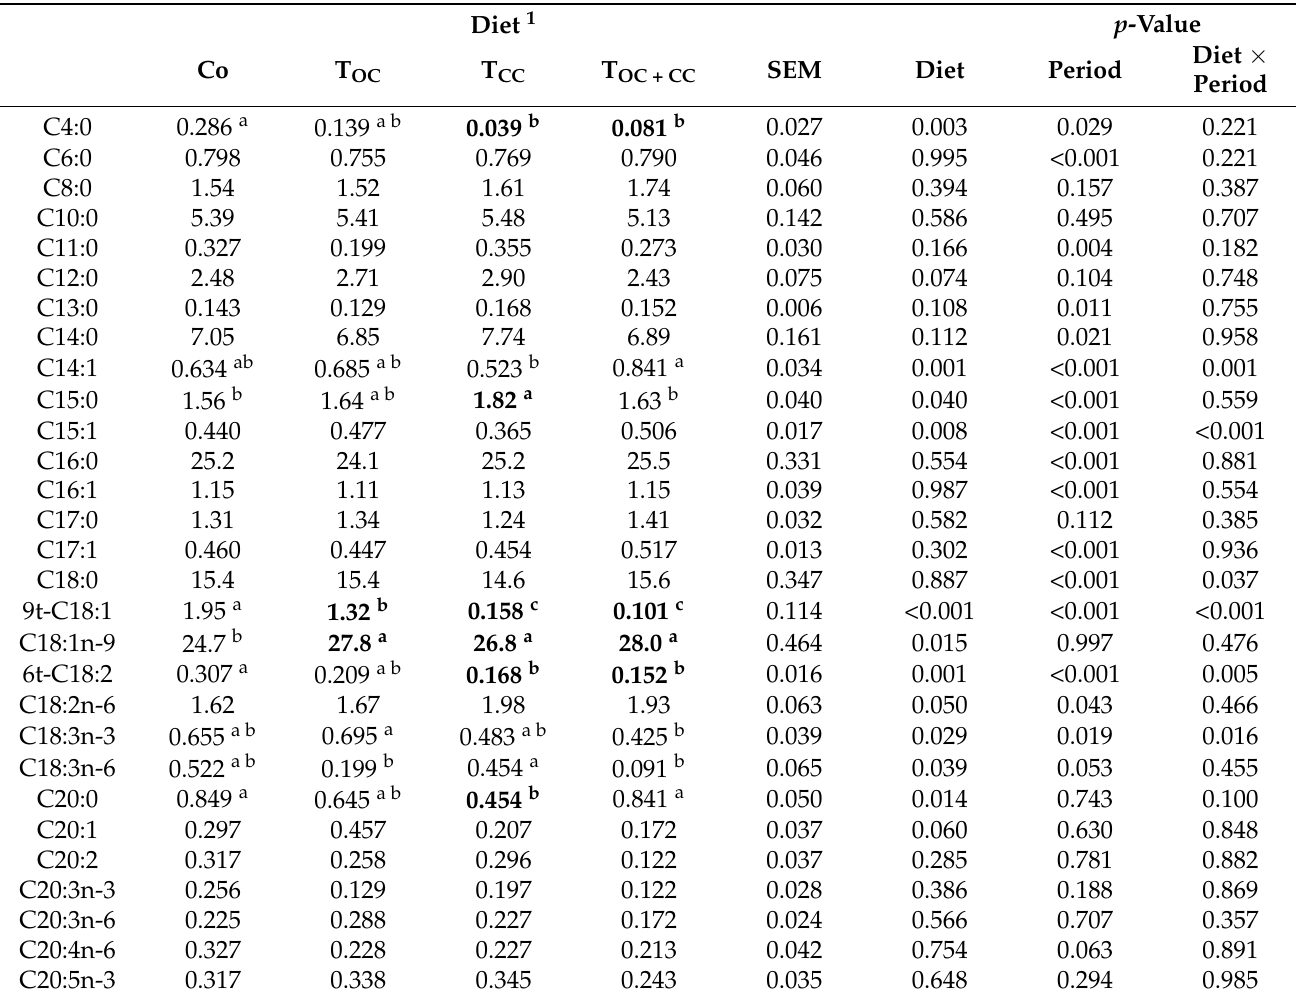
Table 5. Least square means and standard error of the mean of fatty acid profiles (g/100 g fat) and summaries (g/100 g fat), ratios, and indexes in goat milk fat according to diet (n =